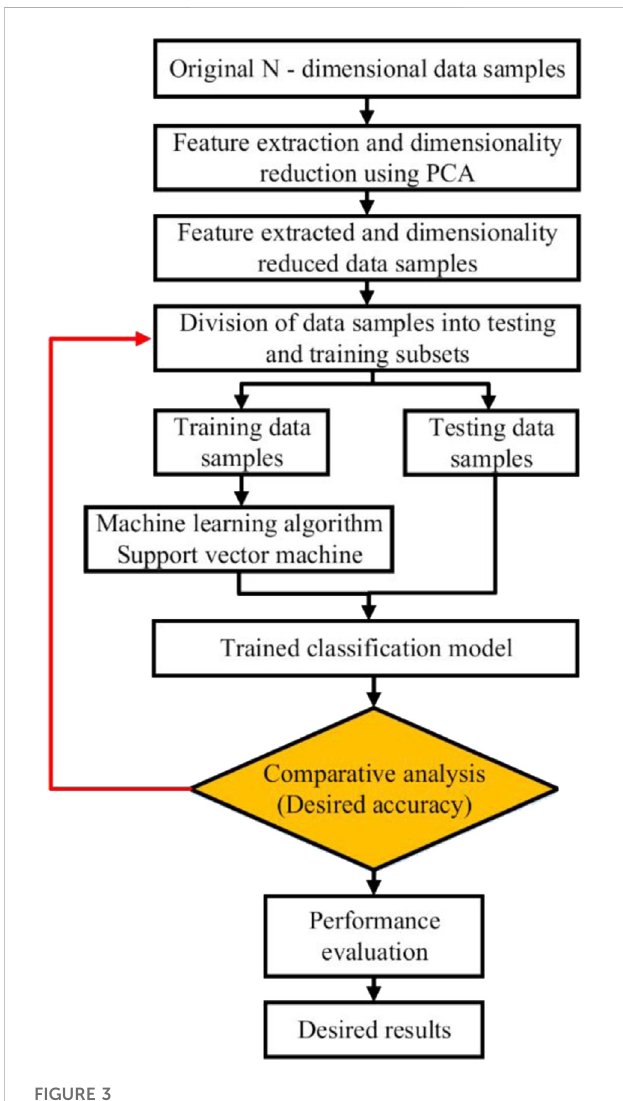
FIGURE 3 SVMmodelimplementation process(Muzzammel and